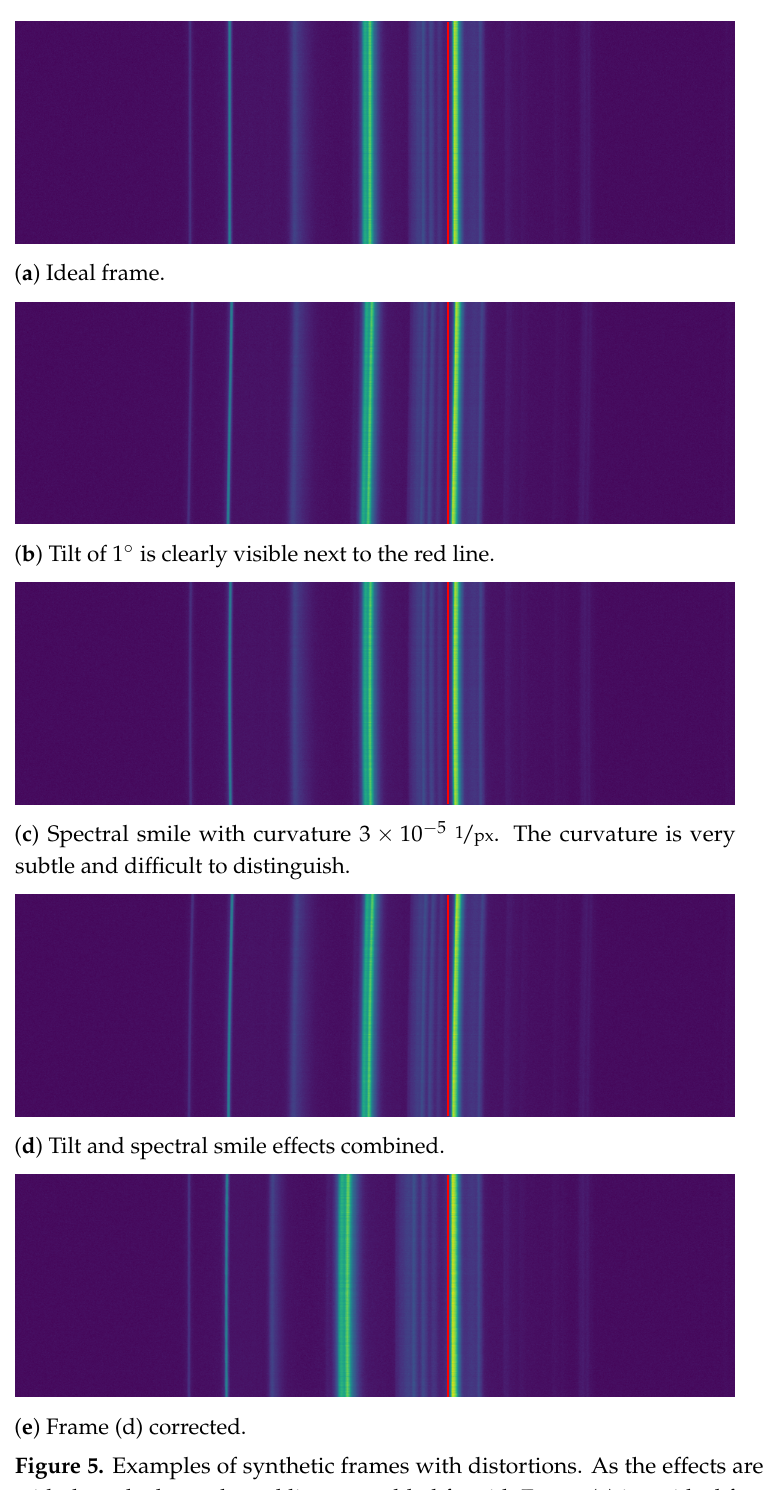
Figure 5. Examples of synthetic frames with distortions. As the effects are difficult to distinguish with the naked eye, the red line was added for aid. Frame ( a ) is an ideal frame that one would hope to get from a push-broom HSI. Frames ( b , c ) show the tilt and spectral smile aberrations, respectively. Frame ( d ) shows both aberrations combined, which represents the real data we get from the imager. Figure ( e ) shows Frame ( d ) after running the correction algorithm. The distortions are no longer distinguishable, but the emission line locations have shifted (see fourth line from the